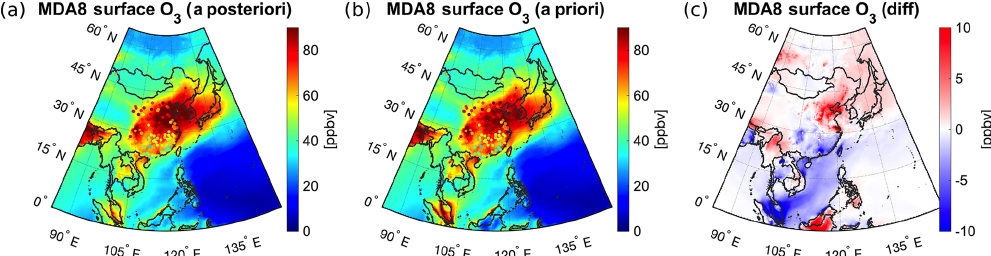
Figure 11. Simulated MDA8 surface ozone using the updated emissions constrained by OMI and OMPS observations (a) , the default ones (b) , and their difference (c) in May–June 2016. We over-plot surface MDA8 ozone values (circles) from the Chinese air quality monitoring network (https://quotsoft.net/air/, last access: 2 June 2020). Table 6. MDA8 surface ozone levels before and after carrying out the inversion for different regions in May–June 2016. Regions The a priori The a posteriori Changes in